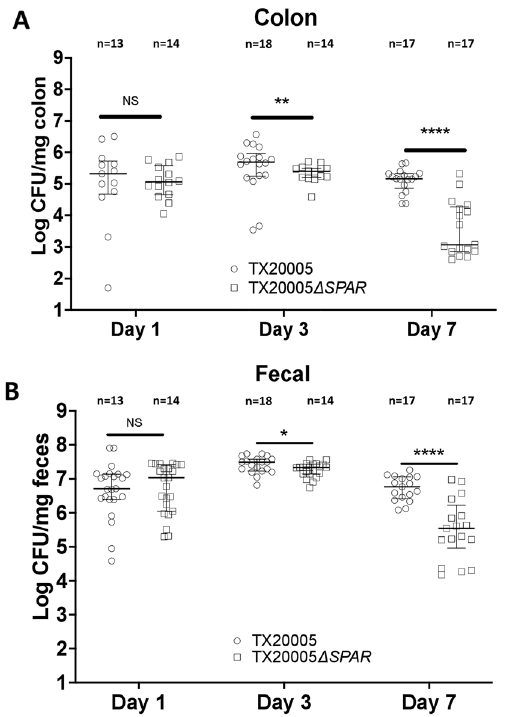
Figure 4. SPAR deletion reduced the colonization capacity of Sgg . This was performed as described in the “Materials and Methods” Section. 13–18 mice were used per group. Colon tissues ( A ) and fecal pellets ( B ) were weighed, homogenized in sterile PBS and dilution plated onto ESA plates. Mann–Whitney test was used for statistical analysis. *, p < 0.05; **, p < 0.01; ****, p < 0.0001; NS, not significant. Median values with interquartile range (IQR) are